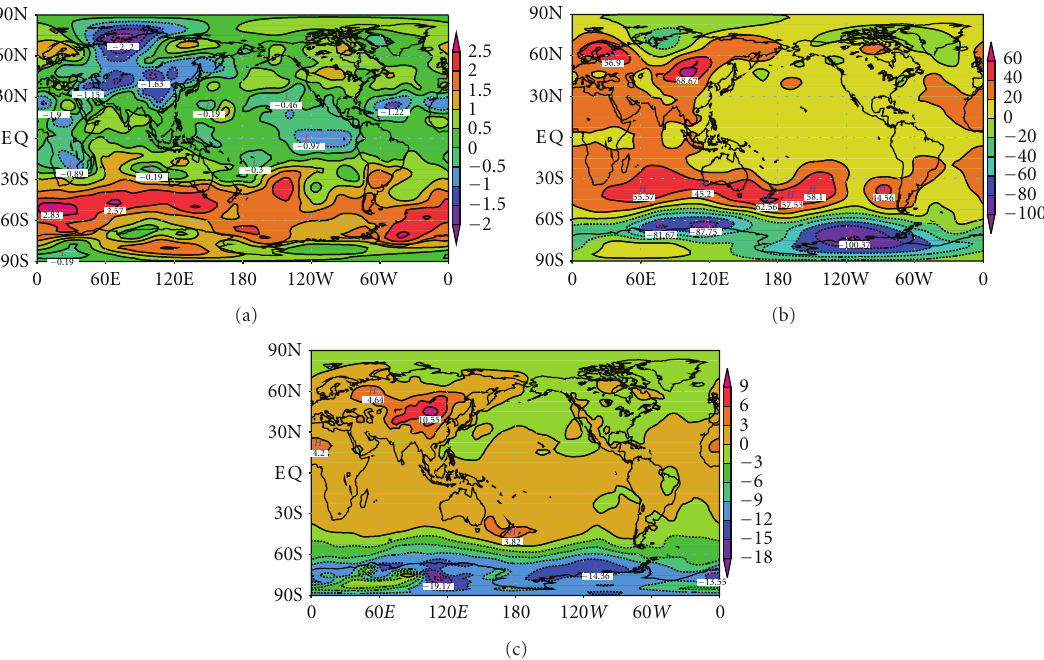
Figure 3: Di ff erence between (1997–2006) and (1949–68) basic states of vertical cross-section of July 500 hPa temperature (K) (a), 500hPa geopotential height (m) (b), and sea-level pressure (hPa)